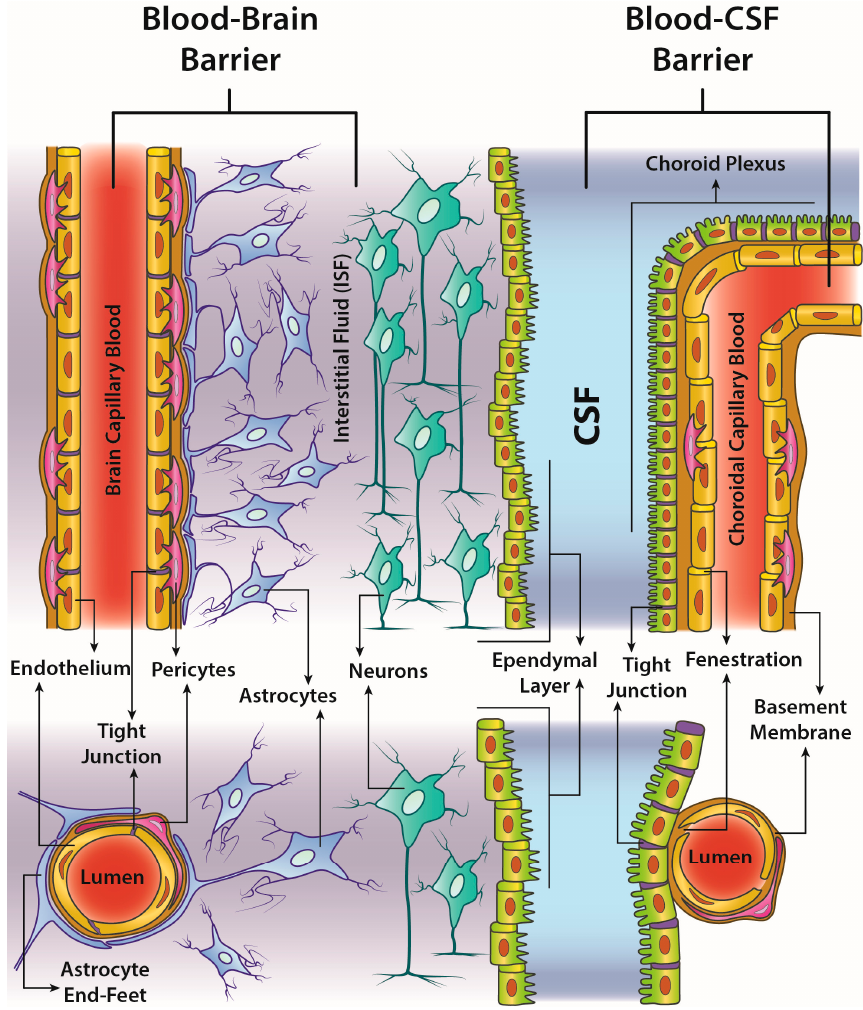
Figure 2. Comparison between the structure of the Blood-Brain Barrier (BBB) and the blood-CSF barrier. ( Left ) BBB separates the lumen of the brain capillaries from the brain parenchyma. The main contribution to the BBB property of reduced permeability comes from the tight junctions (drawn in violet) among endothelial cells lining the capillaries. The so-called neurovascular unit also comprises the pericytes, a basement membrane surrounding both pericytes and endothelial cells and astrocyte end-feet processes from nearby astrocytes. As well as the undisputed role of the tight junctions in sealing the interendothelial cleft, all the elements of the neurovascular unit are likely to contribute to some extent to the augmented selectivity of the BBB. That said, their role is still controversial; ( Right ) The Blood-CSF barrier is found in the choroid plexus of each ventricle of the brain. Unlike the endothelium in the brain parenchyma, capillaries of the choroid plexus have no tight junctions and are fenestrated. However, the choroid plexus is delimited overall by a monolayer of tight-junctioned epithelial cells. This particular epithelium is in direct continuity with the ependymal layer lining the ventricle, though the rest of the ependymal layer is much more permeable. Therefore, unlike the BBB, the blood-CSF barrier is located at epithelial level, while capillaries are relatively leaky and permeable to small molecules, thus allowing, among other processes, the rapid delivery of water through the bloodstream to the surrounding epithelial cells for CSF production in the choroid plexus. Similarly, to what can be found in other tissues of the body, also in the choroid plexus pericytes and a basement membrane wrap around the endothelial cells. Although in principle both the barriers serve the same defensive purpose for the CNS, their distinct structure allows the interchange of different substances between bloodstream and brain. ( Upper part ) Top view; ( Lower part ) Section view.